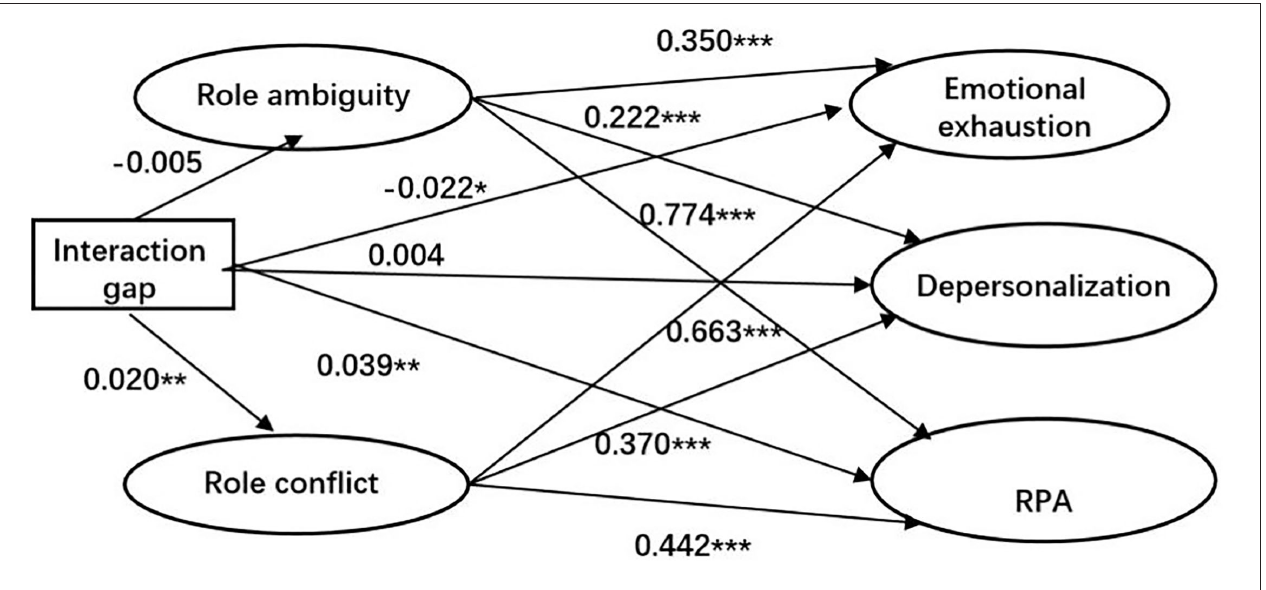
FIGURE 2 | Path coefficient model. * p < 0.05, ** p < 0.01, and *** p < 0.001.